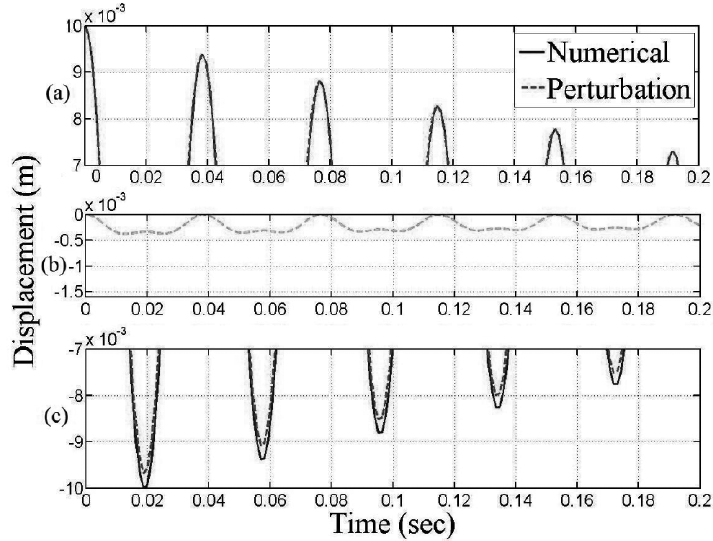
Fig. 4. (a) Response obtained through the perturbation method ( − − − ) in (a) upper peaks of fi rst part, (b) second part and (c) lower peaks of fi rst part and numerical response ( ) for α = 0.5 and β =